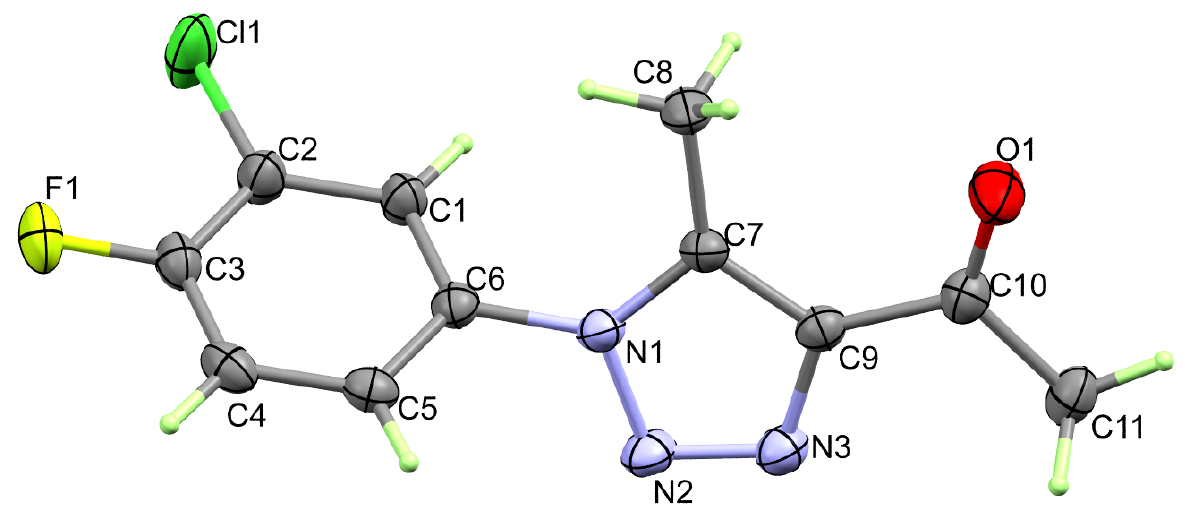
are the phenyl and triazole moieties connected by a C6–N1 bond. The two rings are not coplanar with each other, where the twist angle between the two moieties is 64.15 ◦ .